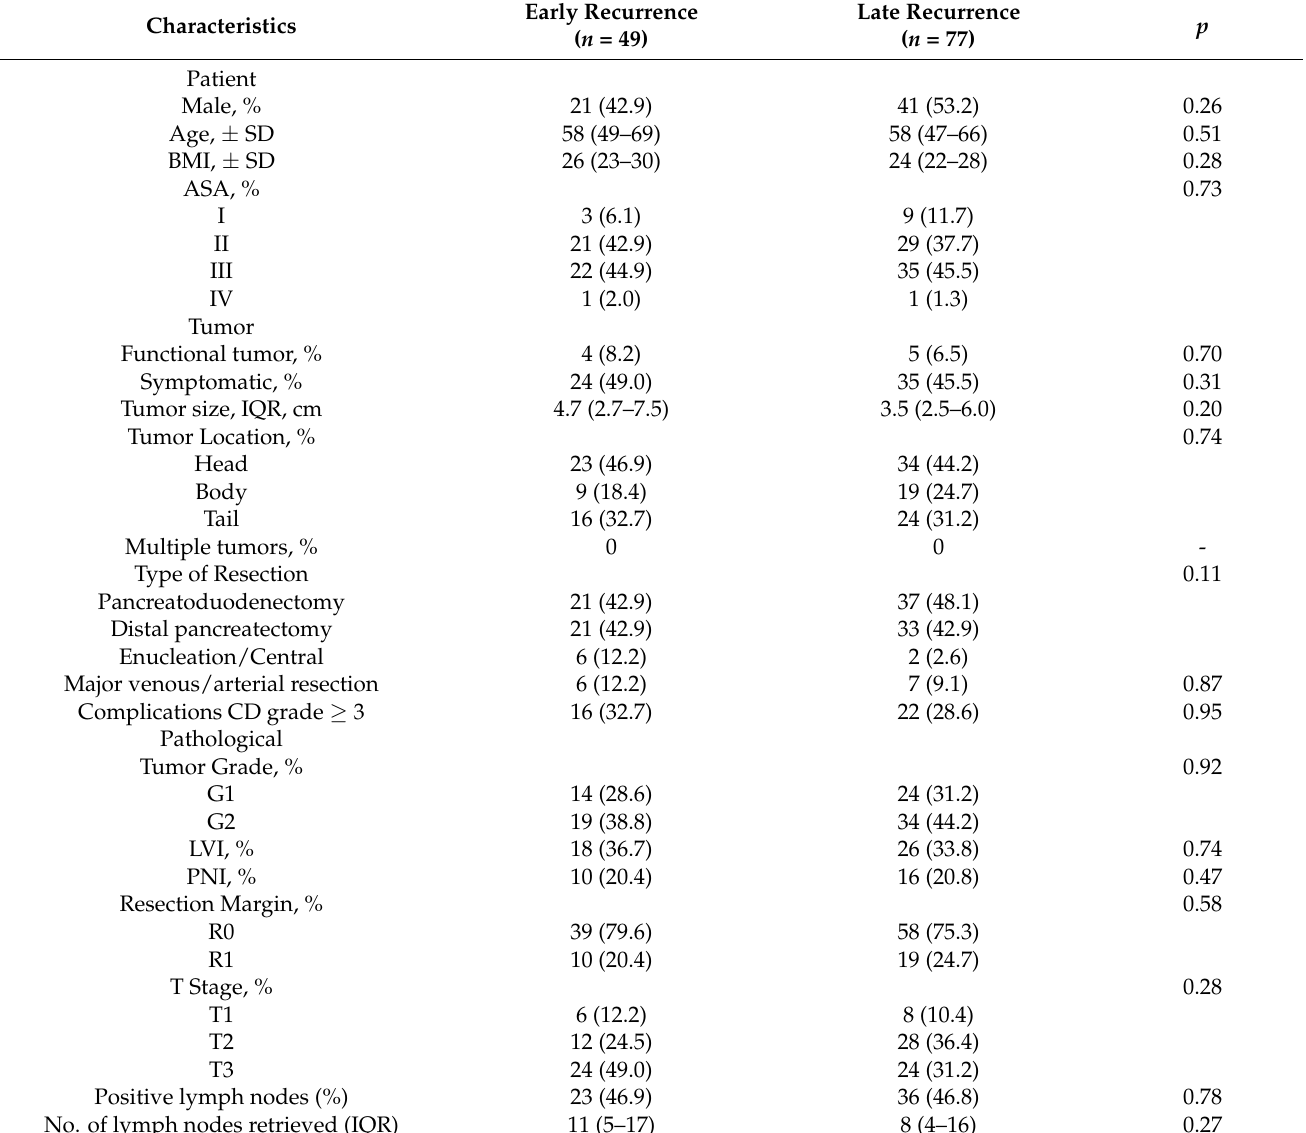
Table 2. Patient and tumor characteristics of patients with early versus late